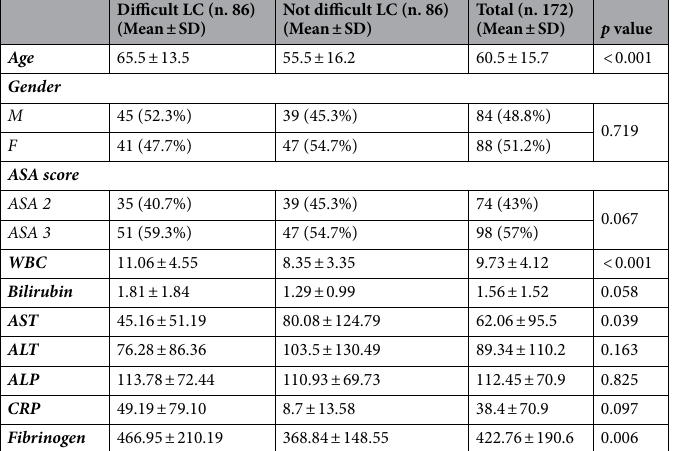
Difficult LC (n. 86)